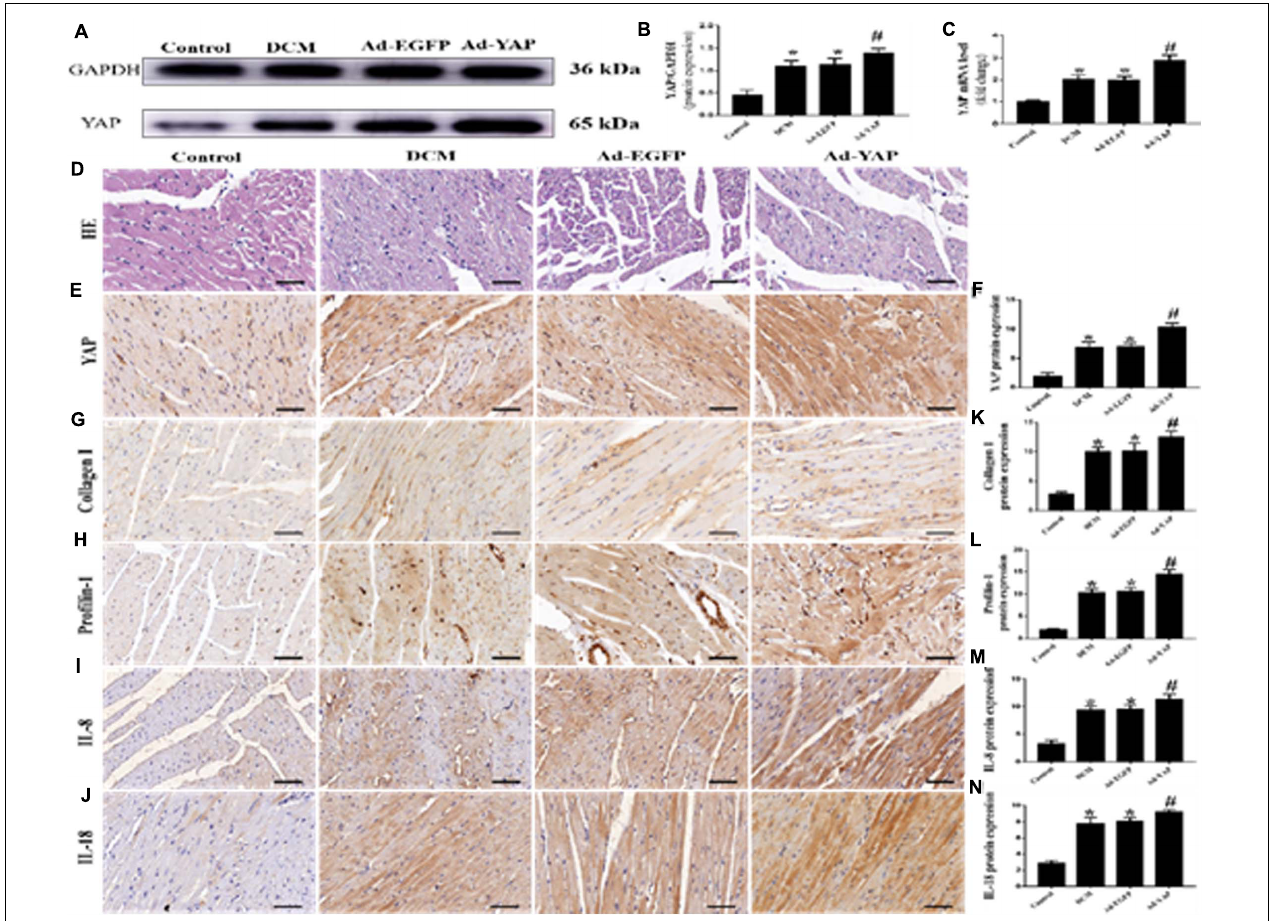
FIGURE 3 | YAP overexpression increased myocardial interstitial fibrosis and inflammation in rats with DCM ( n = 5). (A) western blot analysis of YAP protein expression in the 4 groups. (B) Quantitative analysis of the YAP protein expression shown in panel (A) . (C) YAP mRNA expression. (D) Representative HE staining of cardiomyocytes (scale bar = 20 µ m) in the 4 groups. (E) Representative immunohistochemical staining of YAP in the 4 groups (scale bar = 20 µ m). (F) Quantitative analysis of the YAP protein expression shown in panel (E) . (G–J) Representative immunohistochemical staining of Collagen I, Profilin-1, IL-8 and IL-18 in the 4 groups (scale bar = 20 µ m). (K–N) Quantitative analysis of the Collagen I, Profilin-1, IL-8 and IL-18 protein expression shown in panels (G–J) . * p < 0.05 versus the control group; # p < 0.05 versus the Ad-EGFP